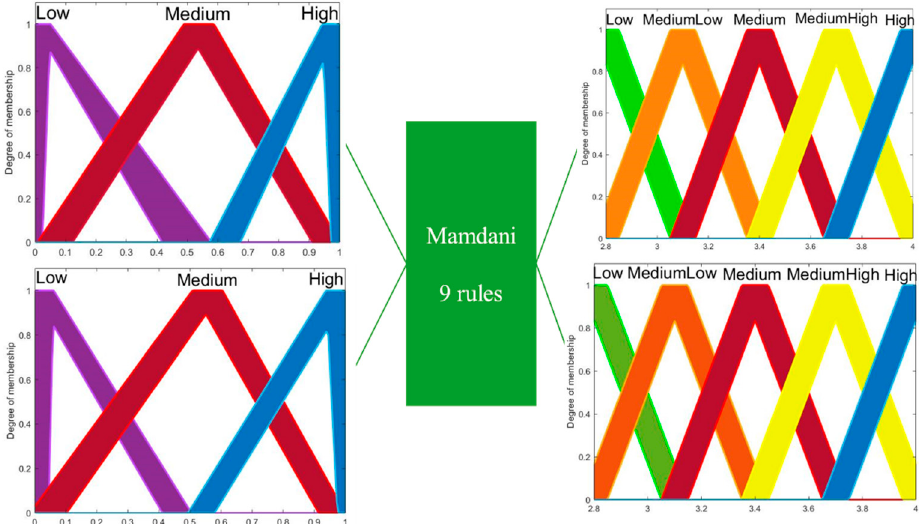
Figure 9. IT2FS proposed for the parameter dynamic adaptation using trapezoidal MFs.